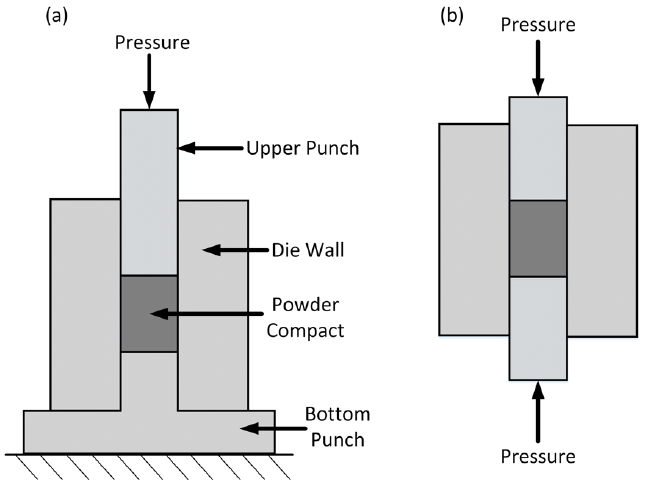
Figure 2. Schematic diagrams of ( a ) single ‐ action die compaction and ( b ) double ‐ action die